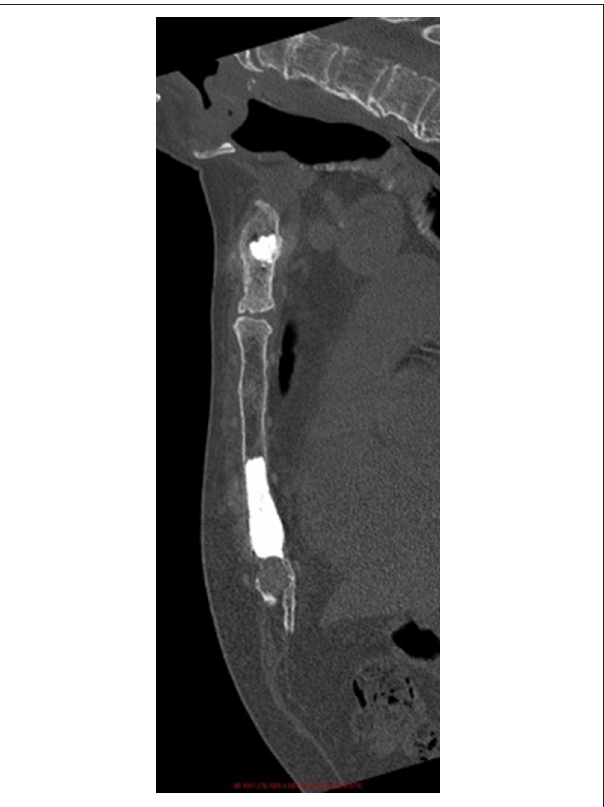
FIGURE 4 | Post-operative sagittal computed-tomography image of patient